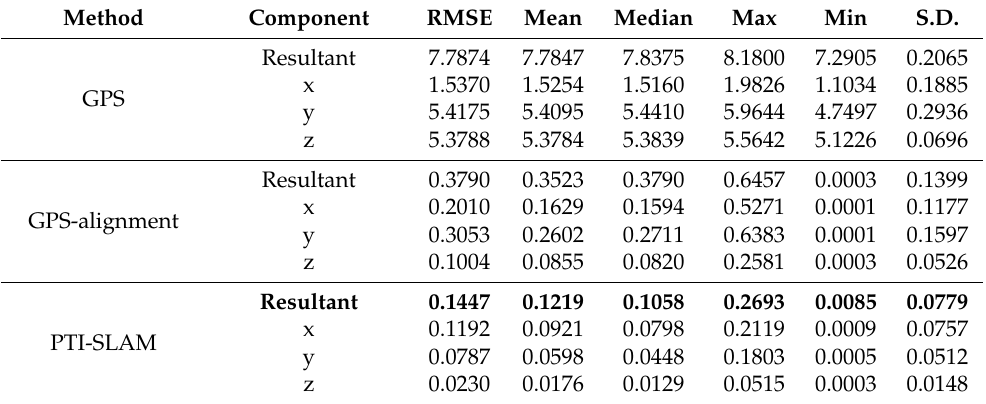
Table 2. The comparison of absolute trajectory error (meters).